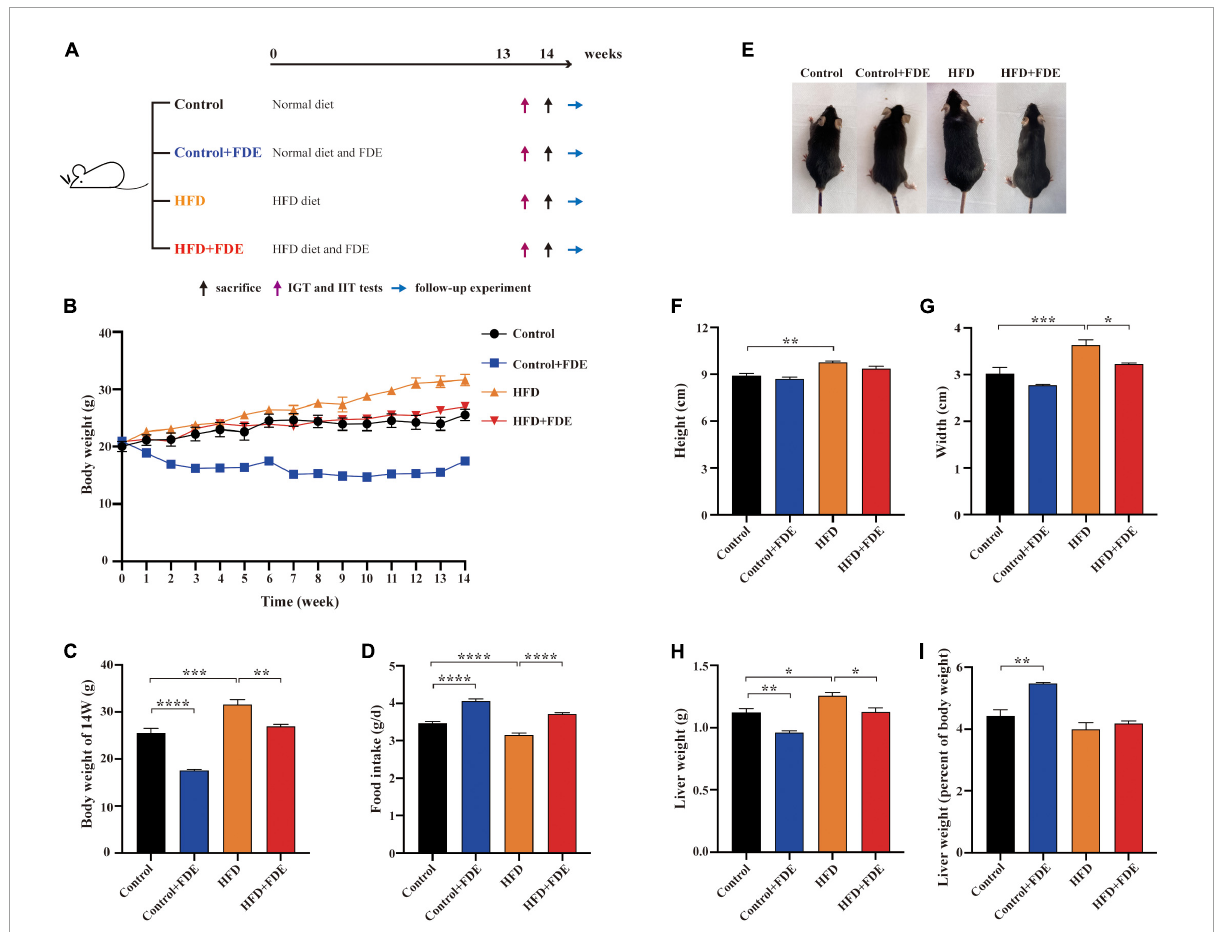
FIGURE1 Effects of FDE on body weight and obesity in HFD-fed mice. (A) Experimental schedule. (B) Body weight change. (C) Body weight of male mice after feeding respective diets for 14 weeks. (D) Daily food intake (per day among the four groups). (E) Whole body image of male mice after feeding respective diets for 14 weeks. Effects of FDE on the body height (F) and width (G) of mice. (H) Liver weight and (I) liver index in each group. The data were analyzed by one-way ANOVA. All values are presented as the means ± SEM, and n = 4–6 per group. Control, normal diet; HFD, high-fat diet; Control + FDE, a mixture of FDE and the normal diet; HFD + FDE, a mixture of FDE and the high-fat diet. * P < 0.05, ** P < 0.01, *** P < 0.001, **** P < 0.0001. HFD group versus the control group, HFD + FDE group versus the HFD group, or control + FDE group versus the control